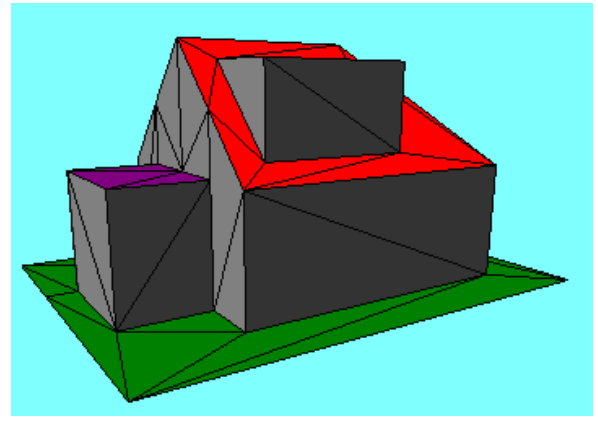
Figure 2. Simple building as a TIN with vertical walls. Roof and terrain triangles are explicit parts of the model, as are vertical lines connecting positions at different heights of a point. Slanted lines at walls are not part of the model, but are added by the rendering software.